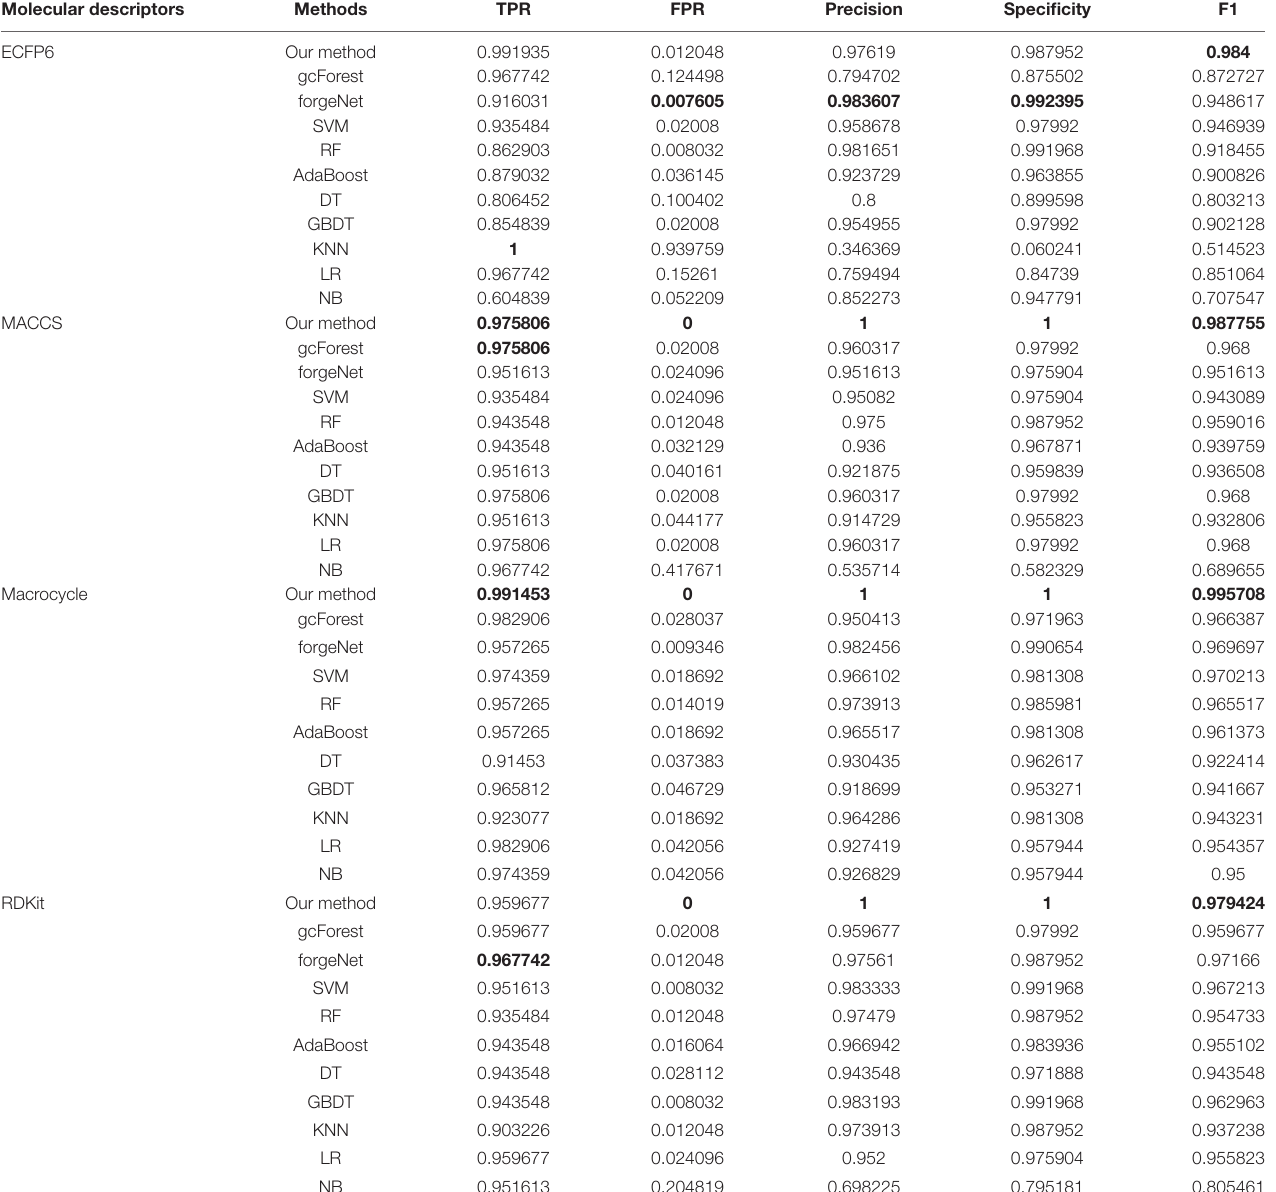
TABLE 2 | Prediction performances of 11 methods with diabetes